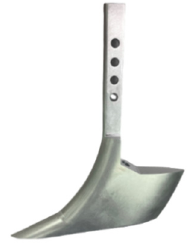
Table 6. Soil parameters.